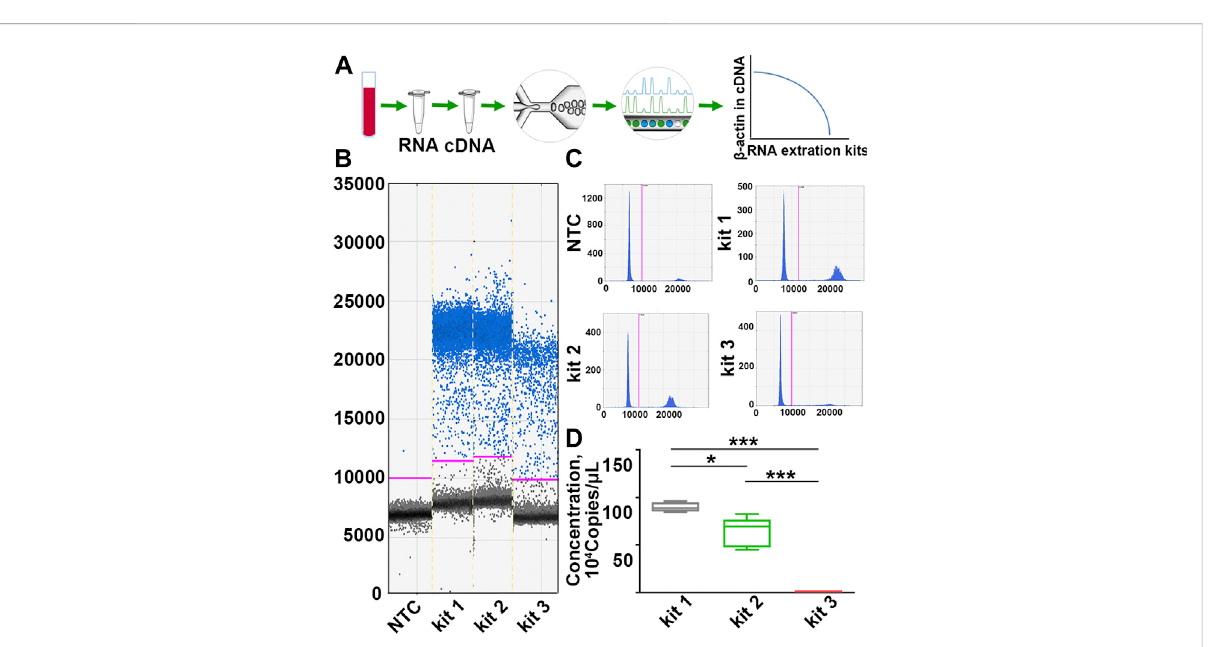
The copy number of β -actin is a more sensitive indicator to identify RNA quality inconsistencies. (A) A scheme for the detection principle of ddPCR. (B,C) Representative one-dimensional plots of droplets measured for fl uorescence signal (ampli-tude indicated on y -axis) emitted from β - actin. Blue dots are positive signals, and black dots represent non-ampli fi cation signals. (D) Quanti fi cation of β -actin copies in samples processed with different RNA extraction kits. n = 30. Data are represented as the mean ± SD ( n = 10). Tamhane ’ s T2 test (D), * p < .05, *** p <